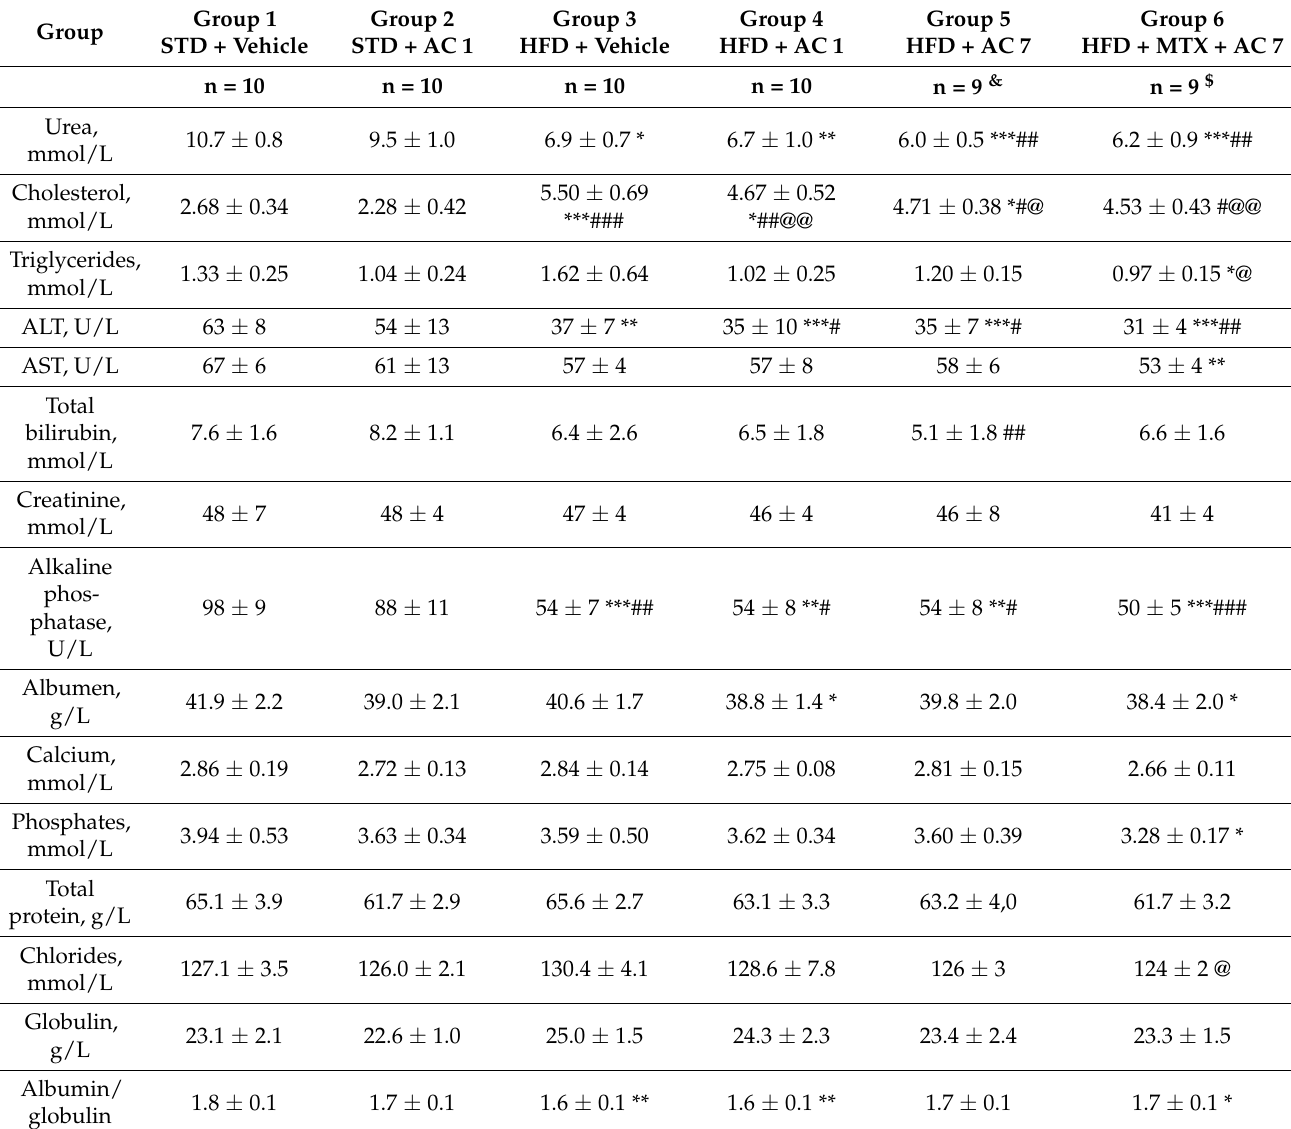
Table 7. Results of biochemical analysis of animal blood